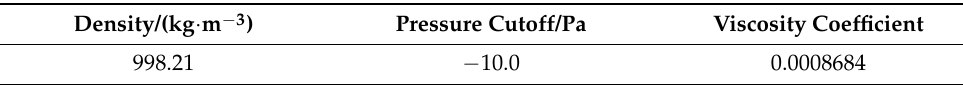
Table 5. Material parameters of water.